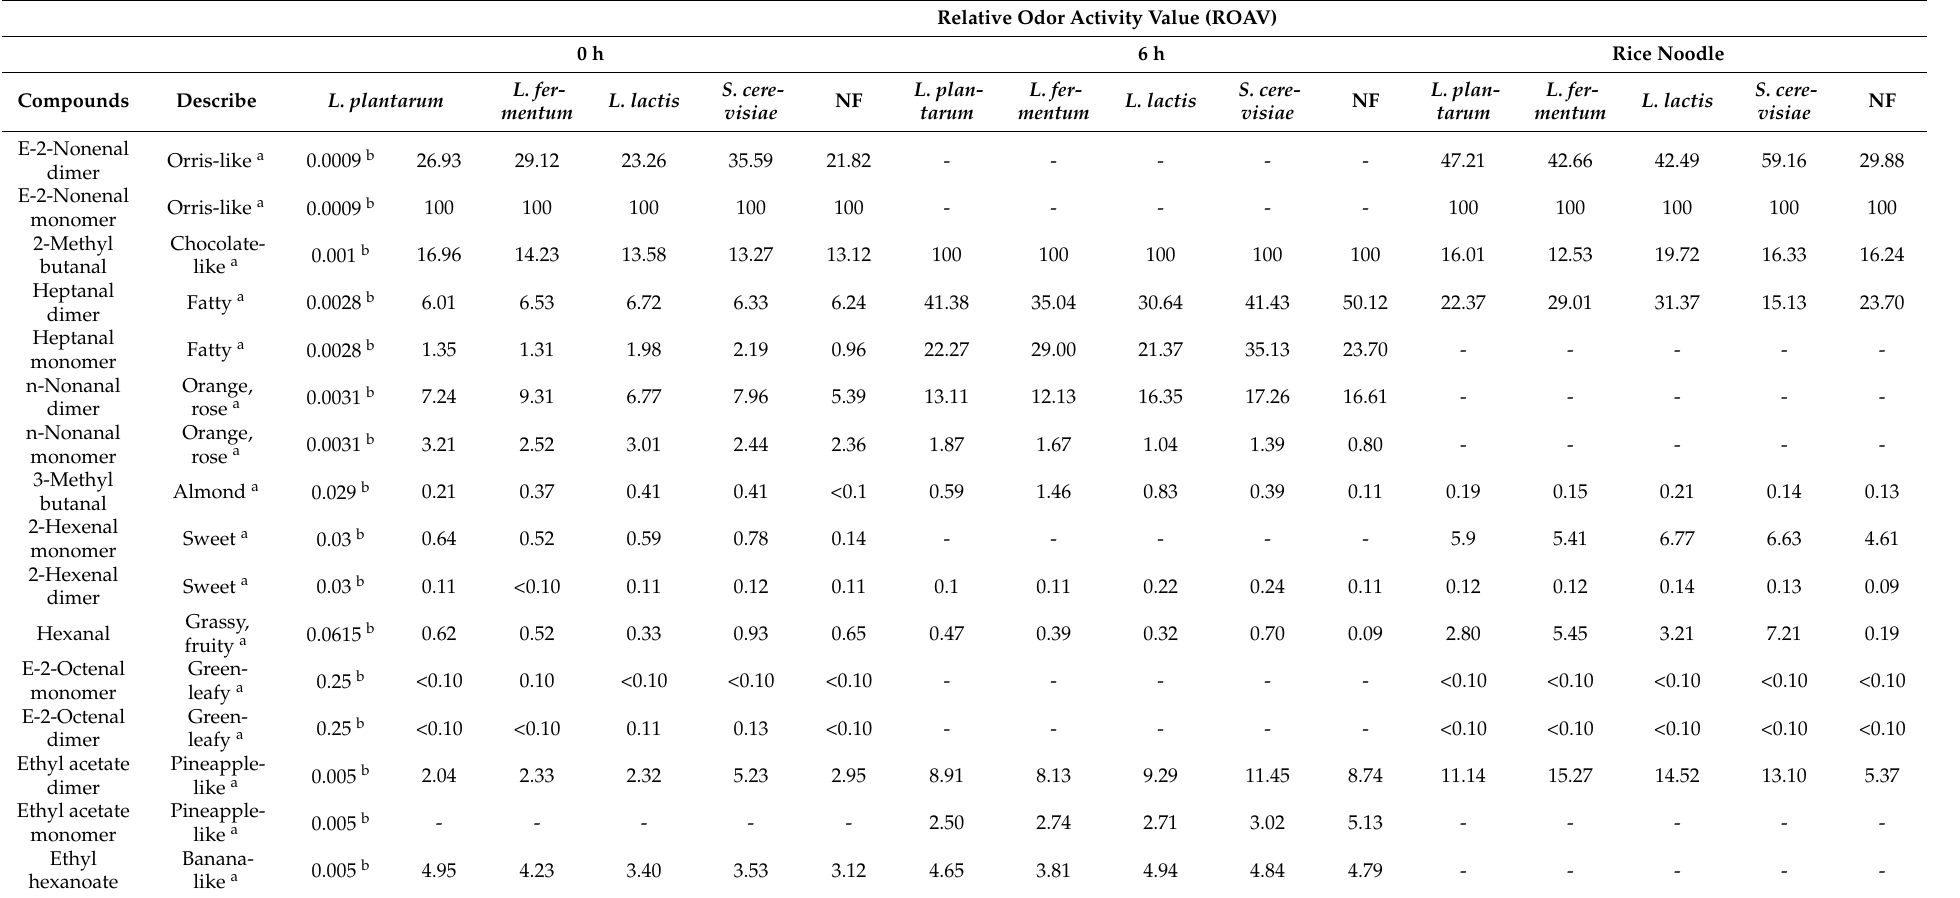
Table 2. Relative odor activity value of volatile compounds detected by HS-GC-IMS in fresh fermented rice